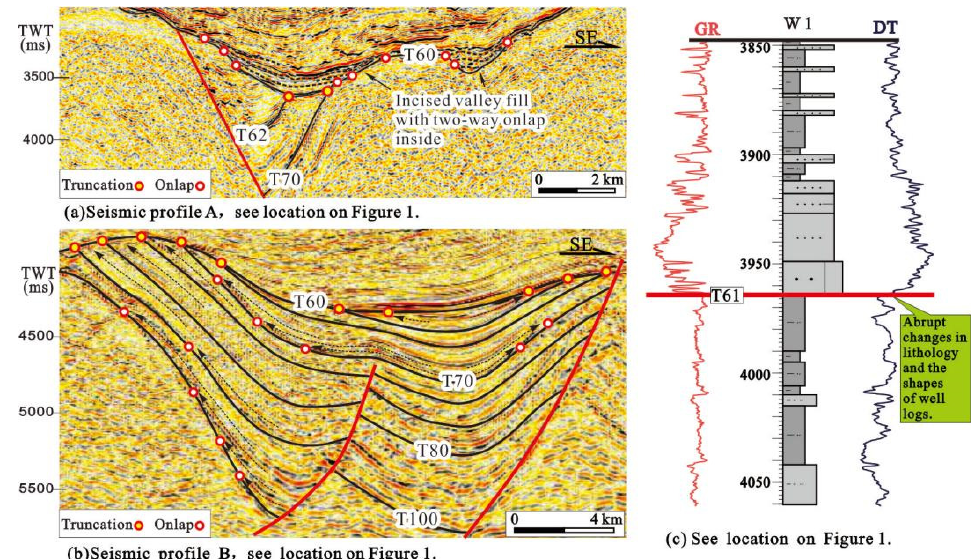
Figure 2. Identification of the sequence stratigraphic surfaces in the Paleogene QDN Basin. TWT means two-way time. ( a ) Above the T60 boundary, incised valleys were developed with obvious truncating of the underlying strata; ( b ) Truncation and onlapping points revealed the unconformable contacts above the sequence surfaces; ( c ) The sequence boundary featured abrupt changes in the well log shapes and lithology.